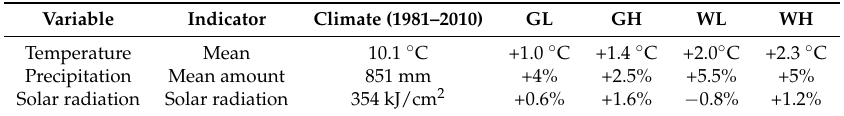
Figure 3. ( a ) Difference in monthly precipitation (P, mm) and ( b ) reference evaporation (ET ref , mm) between the four scenarios and the reference period (1981–2010) averaged over 30 years for one representative grid cell at the centre of the Veluwe. Table 1. Overview of the changes in the most relevant meteorological variables according to the climate change scenarios for the period 2036–2065